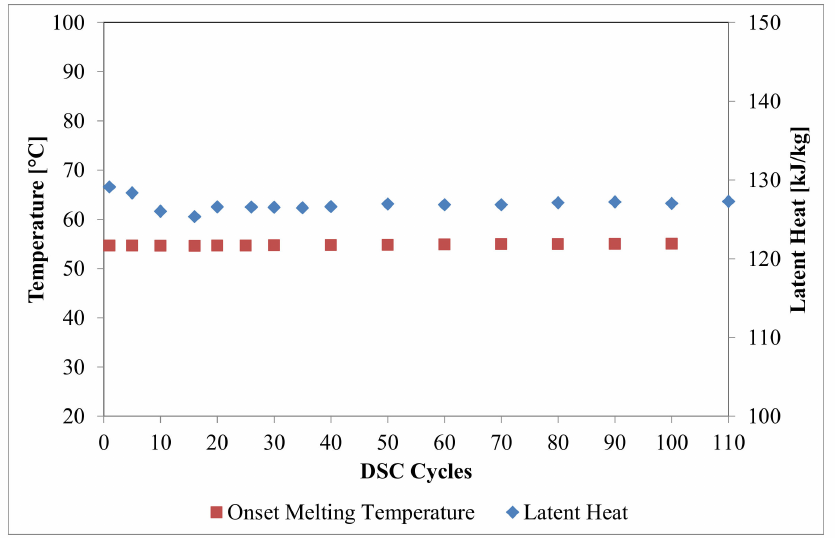
Figure 2. Onset melting temperature and latent heat evaluated over the PCM S58 measured in the DSC